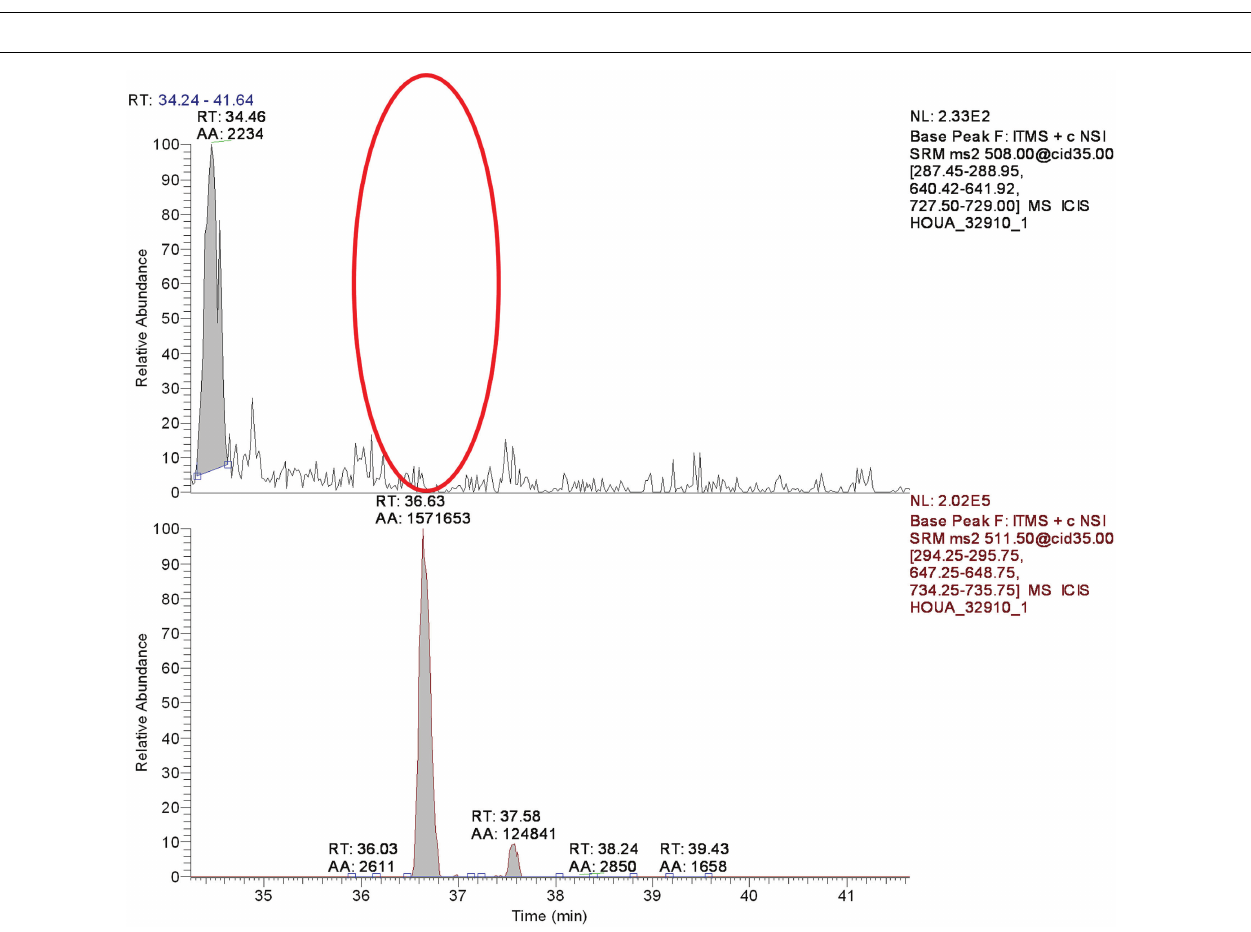
FIGURE 10 | Collision-induced dissociation spectrum of MISHELR, a unique peptide derived from trypsin digestion of PSPHL.